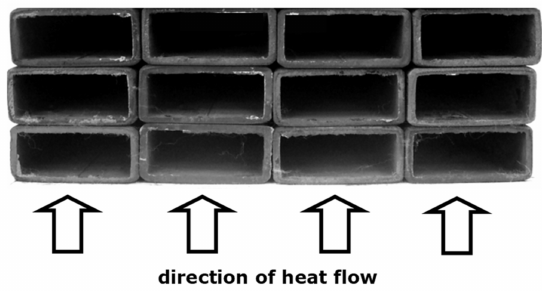
Figure 2. A package of rectangular steel sections with one-dimensional heat